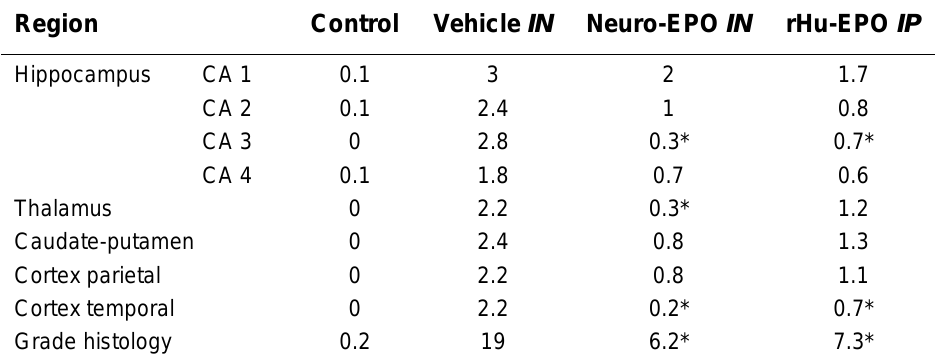
Semi-Quantitative Evaluation of the Histological